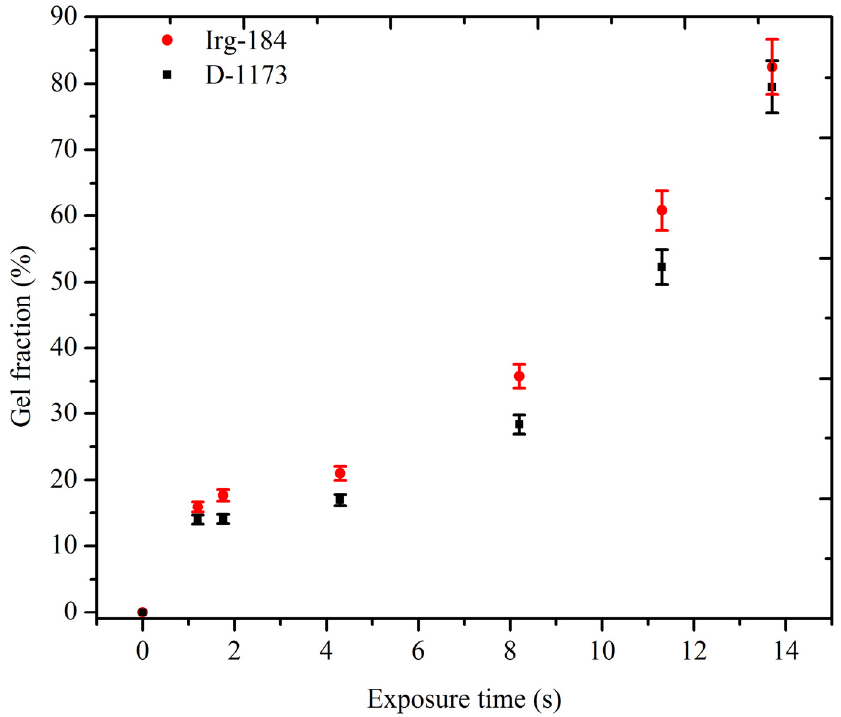
Figure 9. Gel Fraction Percentages of the UV cured EPOLA Films ( ■ ) Photoinitiator D-1173 ( ● ) Photoinitiator